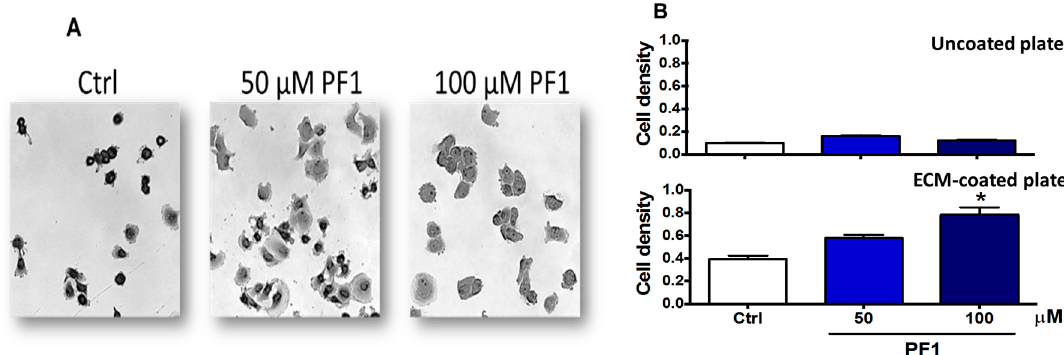
Figure 8. PF1 promotes the adhesion of MDA-MB-231 cells. MDA-MB-231 cells (4 × 10 6 cells / well) were seeded in a six-well plate. The following day, media was replaced with media containing 1% FBS and supplemented with vehicle alone (Ctrl), 50, or 100 µ M PF1. After 24 h of incubation, cells were detached and seeded on uncoated (plastic) or pre-ECM-coated 96-well plates. Cellular adhesion was allowed for 1 h at 37 ◦ C, and cells were then stained with crystal violet. After drying, pictures were taken before quantification. Panel ( A ) shows cells seeded on an ECM-coated plate. Panel ( B ) shows the quantification of intracellular CV. The following symbol denotes a statistical significance when compared to the control group: *, p < 0.05.